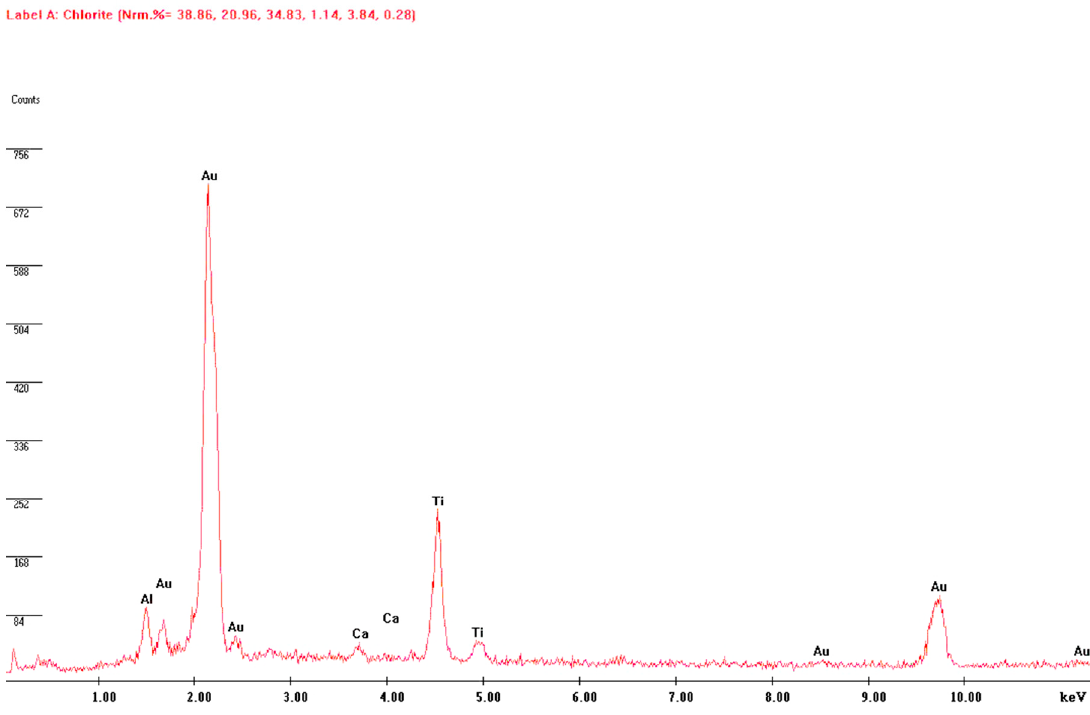
Figure 2. Chemical components of implant. Titanium (Ti), calcium (Ca), aluminum (Al) and gold (Au) were the most commonly detected elements. Some of these are probably related to the coating used to process the samples before the scanning electron microscope (SEM) observation. Kev: Kilo electronvolts; Counts: number of elements presented.